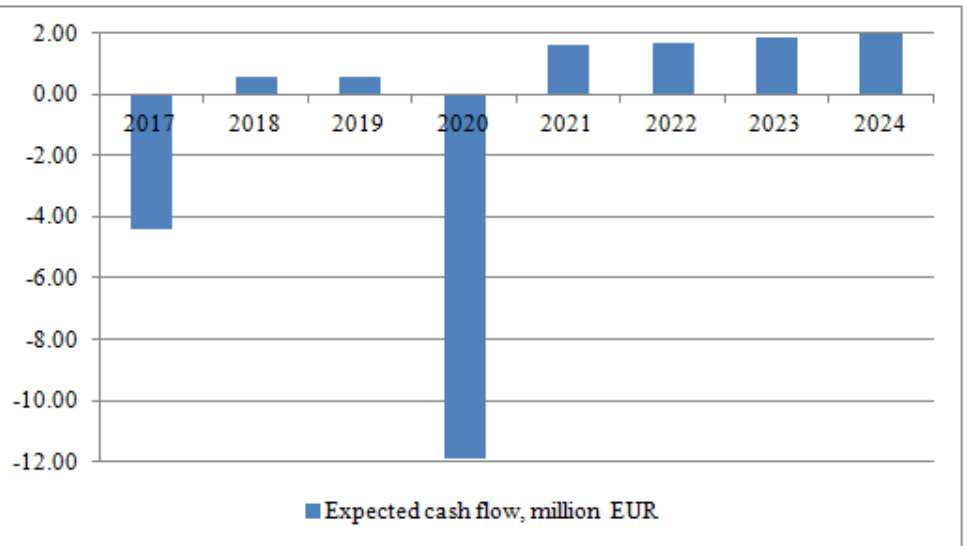
Fig. 1. Expected cash flows of the strategic investment program (Source: Table